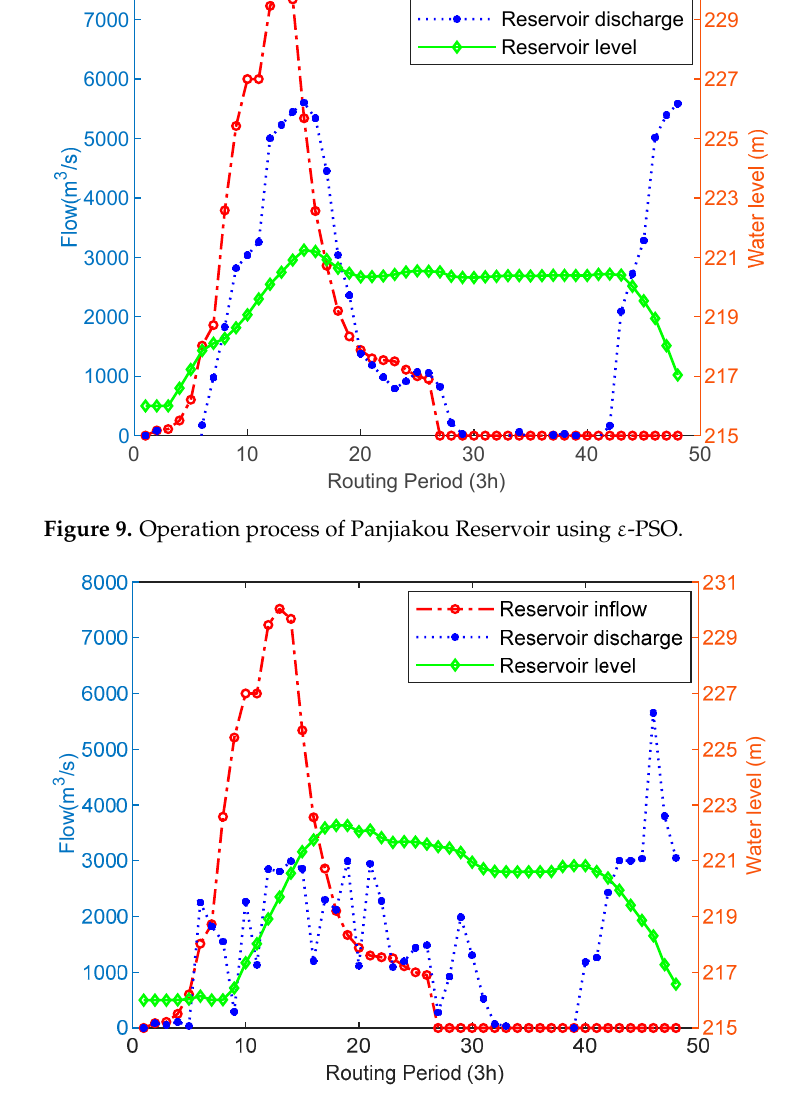
Figure 10. Operation process of Panjiakou Reservoir using CF-PSO. Table 6. Comparison of operation results of different algorithms for Shafan Reservoir.